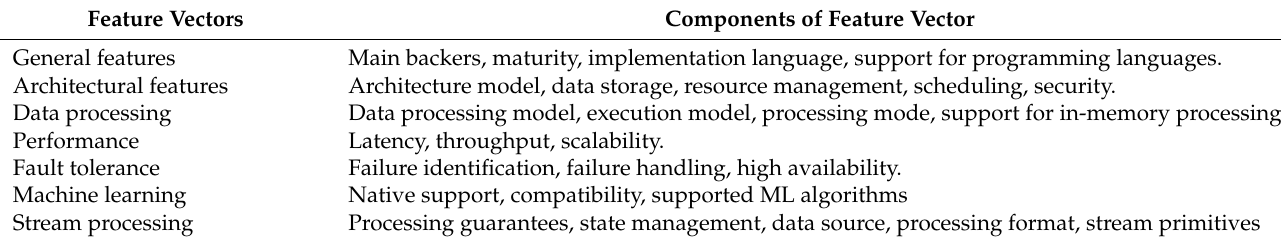
Table 2. Description of feature vectors.